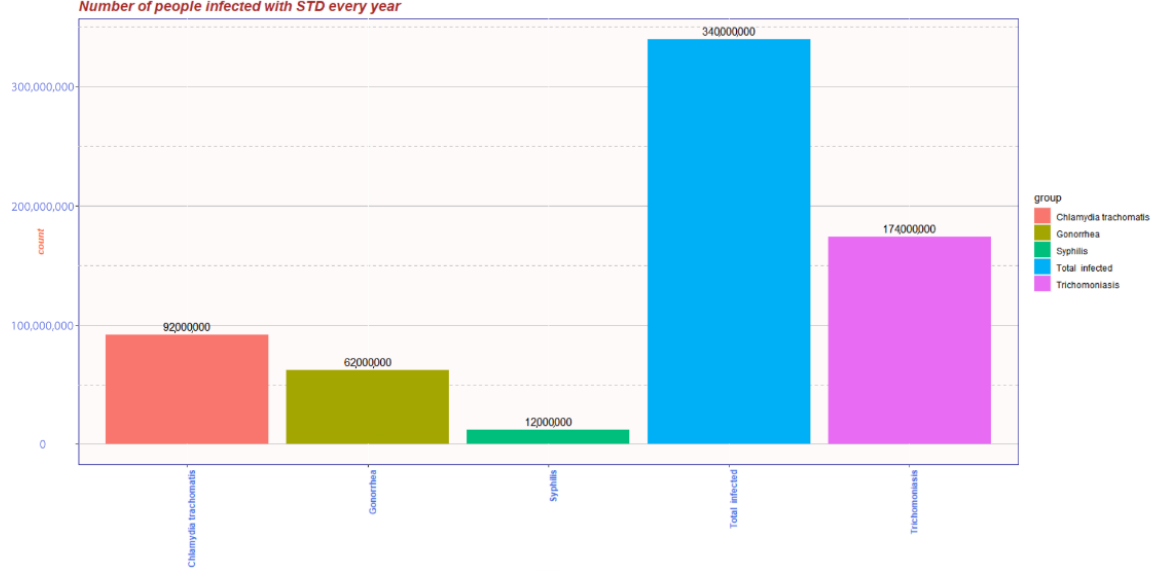
Figure 19. Virtualization of the number of people infected with STDs every year using the R programming language.